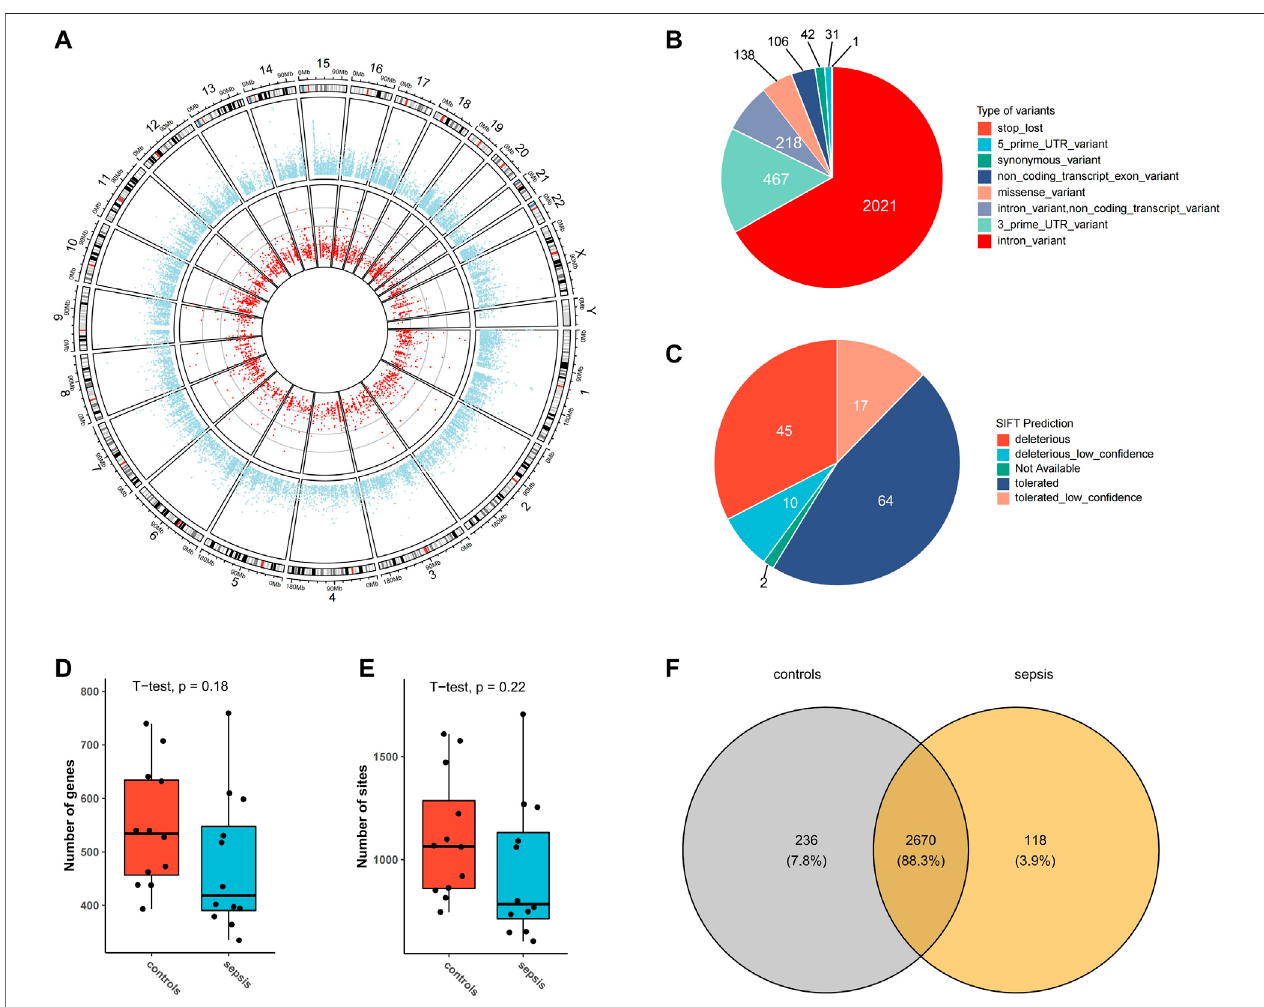
FIGURE1| A-to-IRNAeditingsitesidenti fi edfromhumanbraintranscriptomeinthecurrentstudy. (A) Circosplotoftranscriptiongeneexpression(outercircle)and A-to-I RNAeditingsites (innercircle)inthehumanbrain. (B) FunctionalcategoriesofA-to-IRNAeditingdetected. (C) SIFTprediction ofmissensevariants Boxplotofthe number of editing genes (D) and sites (E,F) Venn plot of A-to-I RNA editing sites in sepsis and controls.